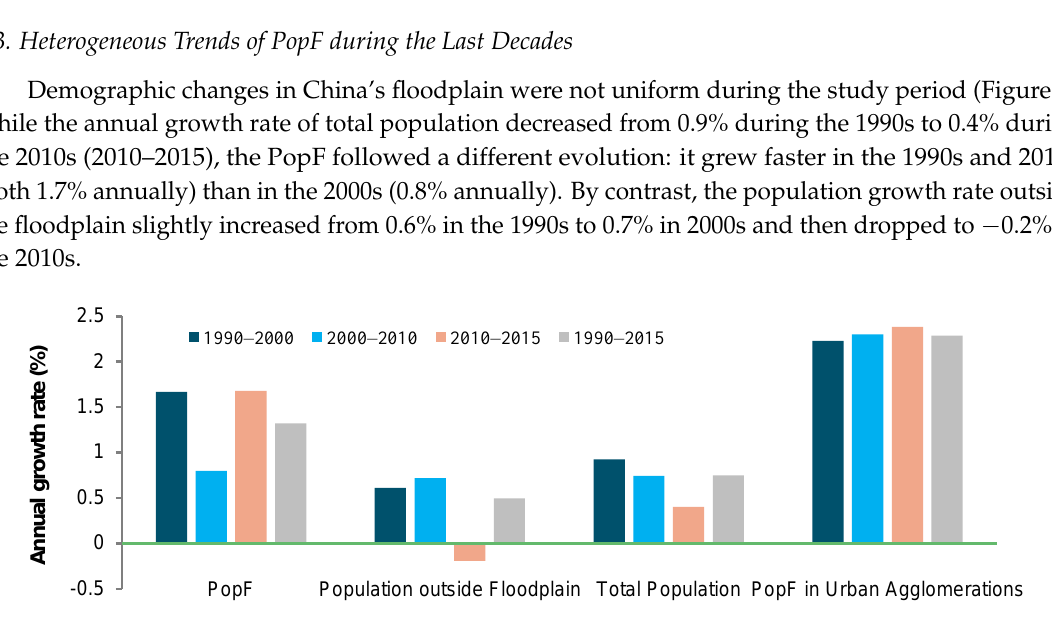
Figure 4. The annual growth rate of population in the floodplain during 1990–2015. Note: refer to Figure 1 for the abbreviations of the regions.